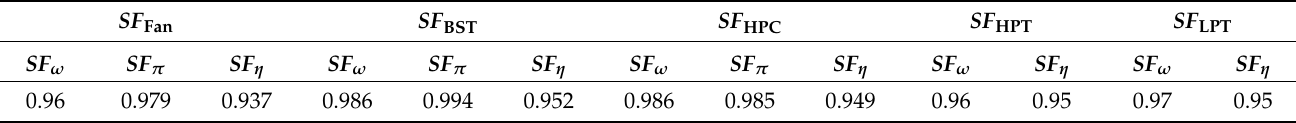
Table 3. The SFs of operating condition ( H = 0, Ma = 0, PLA = 60 ◦ ).